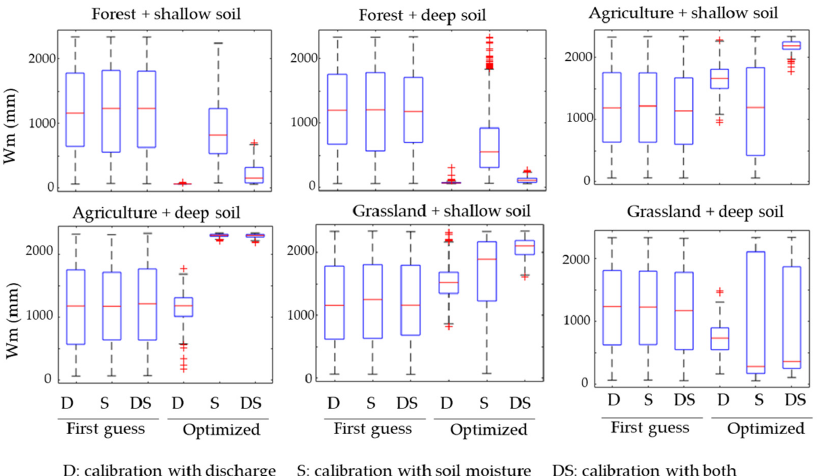
Figure 8. Ranges of Wm parameter (maximum soil water storage) values for the initial first guess and the optimized sets.